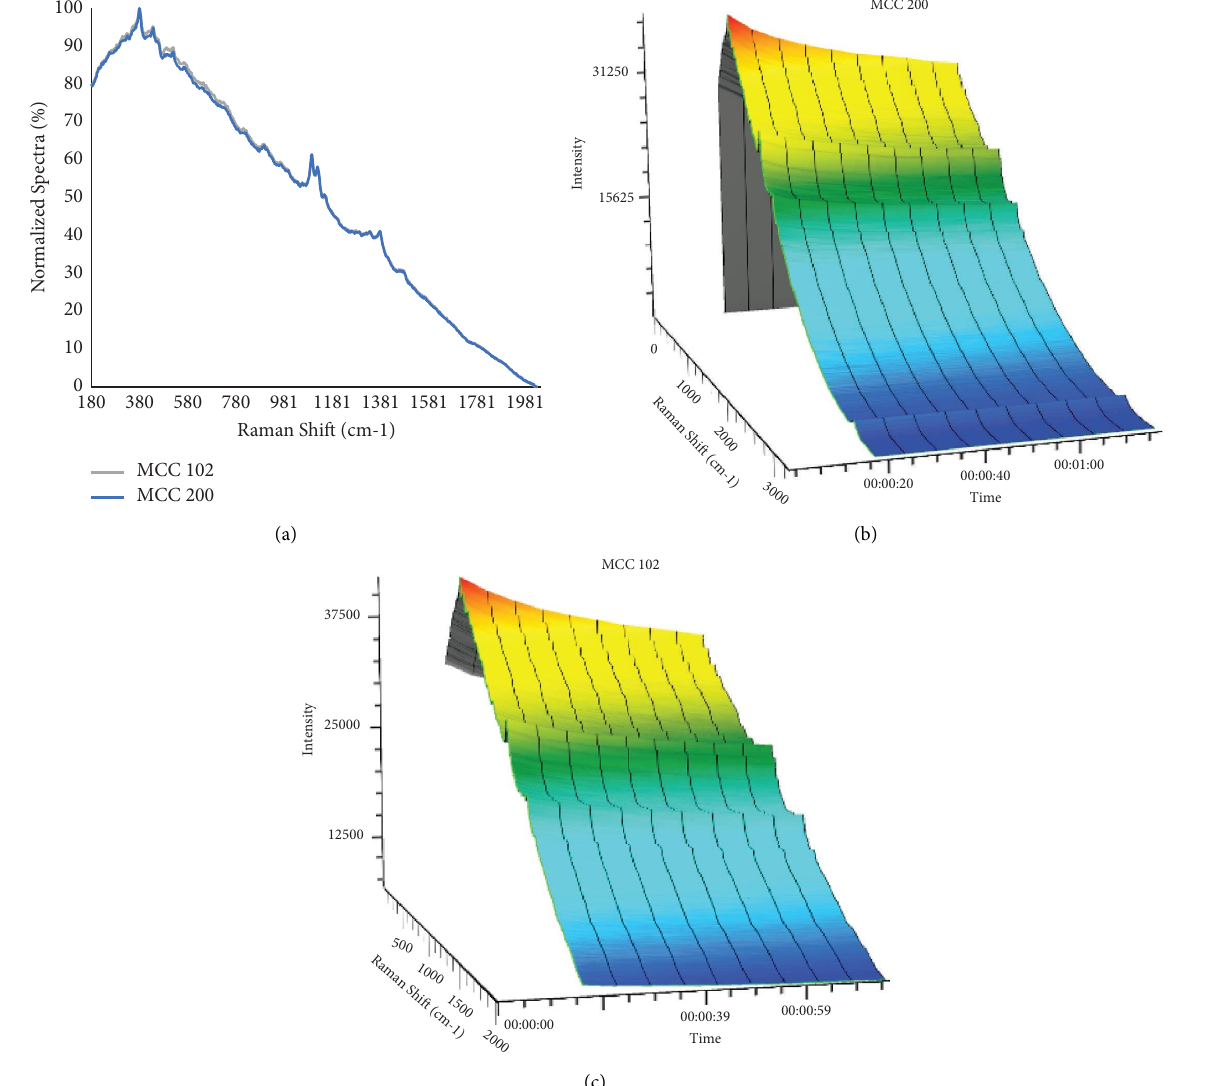
Figure 3: (a) Raman spectra of MCC 200 and MCC 102, (b) surface plot of Raman spectra of MCC 200, and (c) surface plot of Raman spectra of MCC